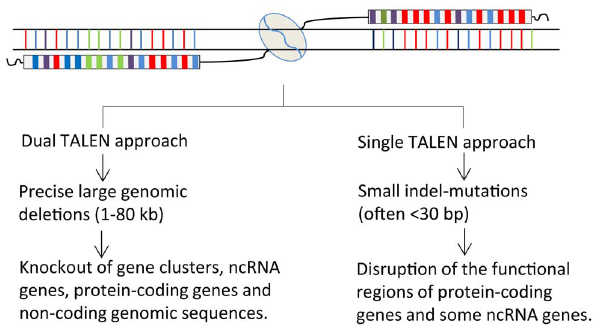
Figure 5. Schematic diagram illustrating knockout strategies using dual or single TALEN approaches. The dual TALEN approach could generate precise large genomic deletions (1–80 kb), allowing knockout of large gene clusters, ncRNA genes, protein-coding genes and non-coding regulatory sequences. The single TALEN approach could produce small indel-mutations of the targeted genomic loci (often , 30 bp), allowing disruption of individual protein-coding genes or some individual ncRNA